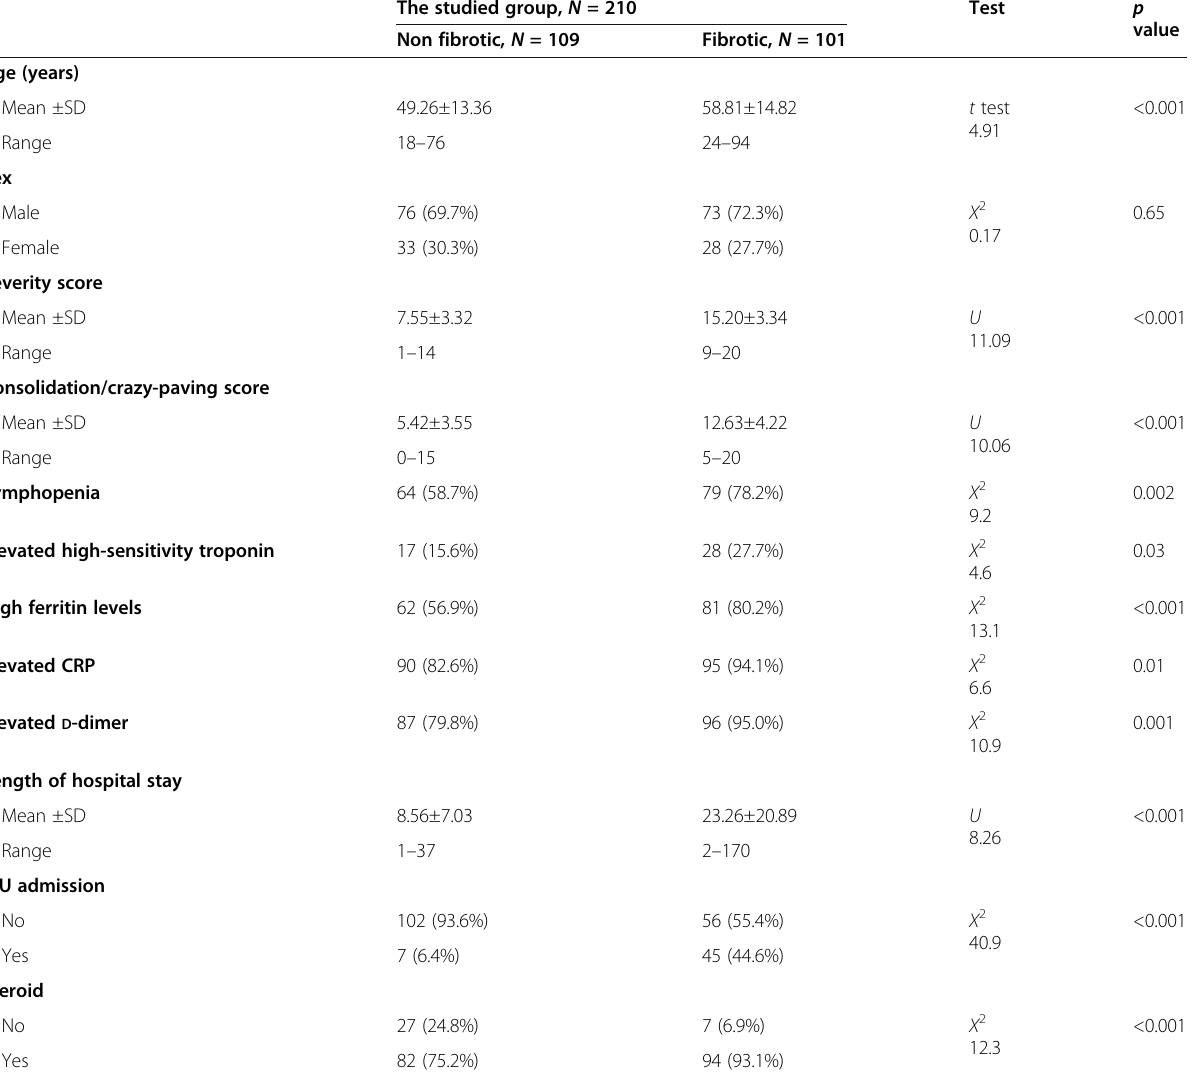
Table 3 Comparison between COVID-19 patients with and without evidence of fibrosis. Non-fibrotic group ( n =109); fibrotic group ( n =101) The studied group, N =